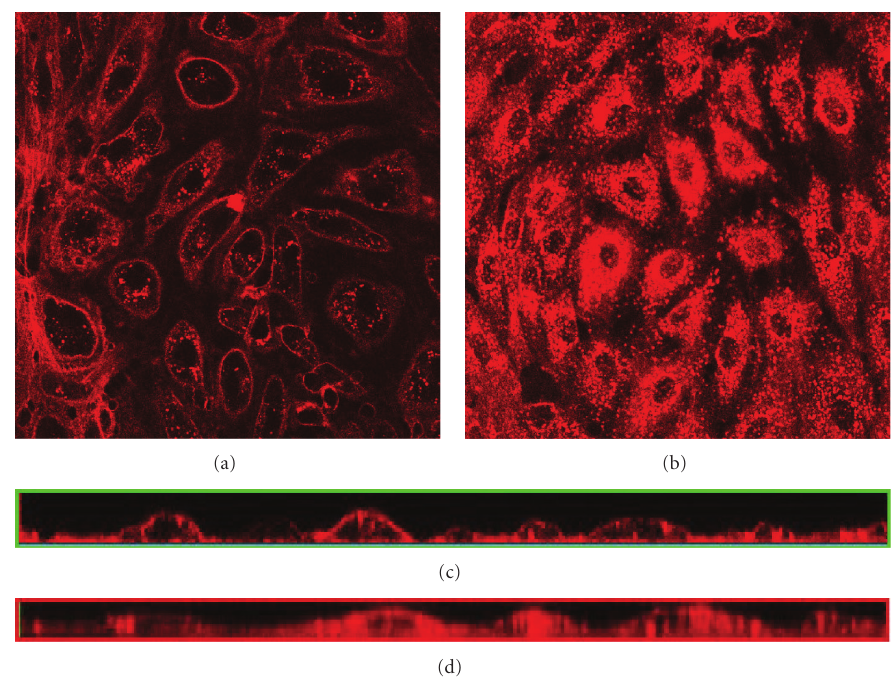
Figure 3: E ff ects of PAO on internalization of FITC-conjugated lectins. The GL is visualized under the confocal microscope through staining of heparan sulfate with Texas Red-conjugated lectin after 24 hours in culture. (a) Cells grown in static condition, 45 minutes prior to staining medium were changed to EMDM with 10 µ M Phenyl Arsine Oxide to prevent endocytosis, (b) cells grown under static condition. Images are cross-sections of the cell monolayer z = 0.5–2 µ m with z = 0 at the glass surface, (c) cross-sections from the side of the stack of images of (a) created with confocal microscopy, and (d) cross-sections from the side of the stack of images of (b) created with confocal microscopy.